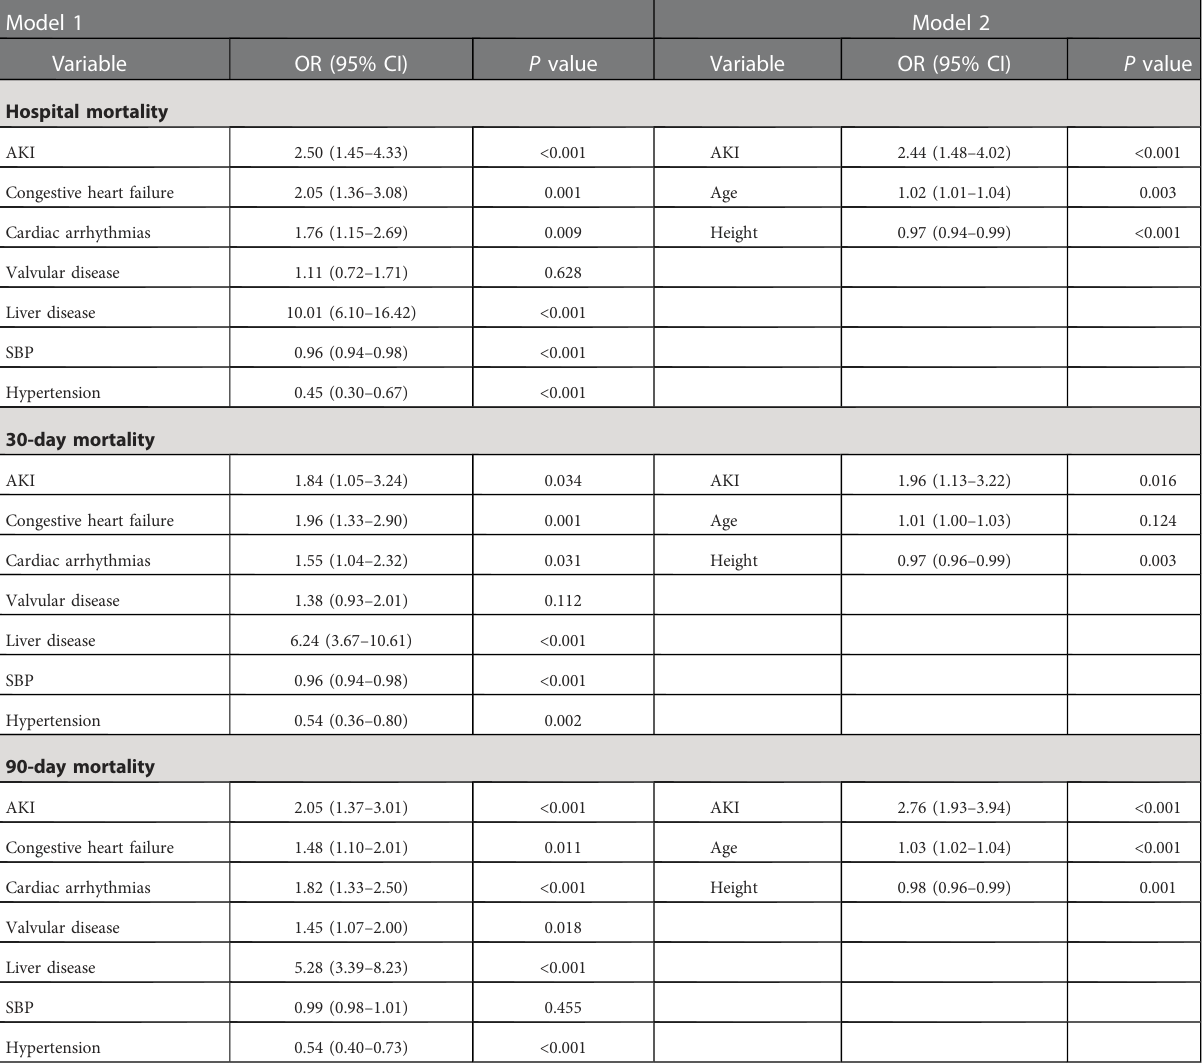
TABLE 4 Multivariate logistic regression analyses for prognosis in cardiac surgery patients. Model